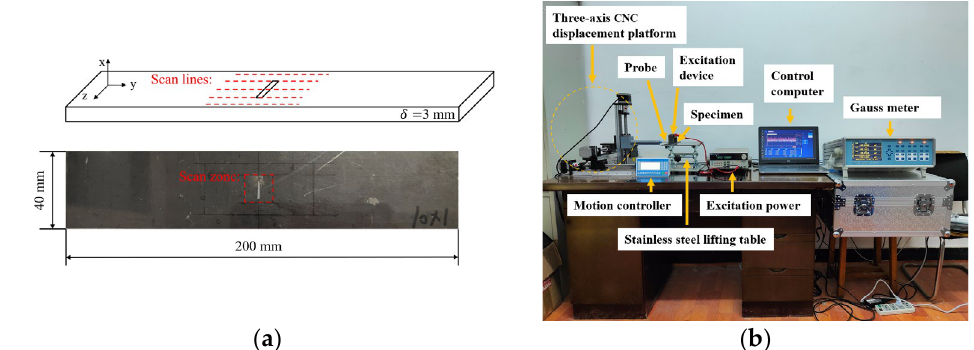
Figure 1. Enhanced metal magnetic memory testing system and specimen diagram. ( a ) Q235 speci- men. ( b ) Enhanced metal magnetic memory testing system.